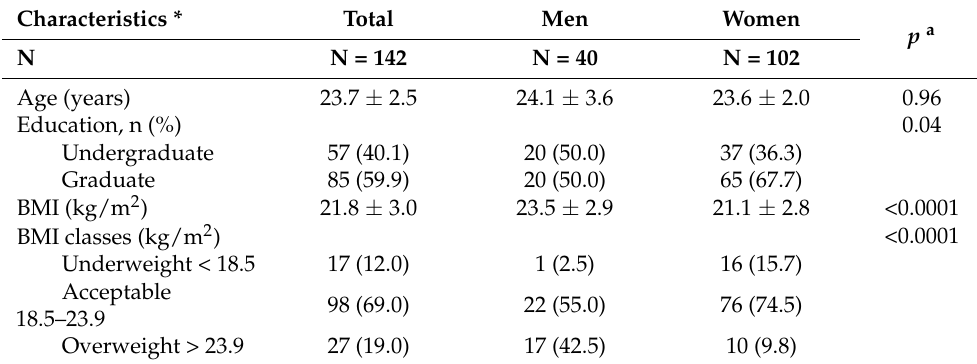
Table 1. Baseline characteristics of study participants ( n =